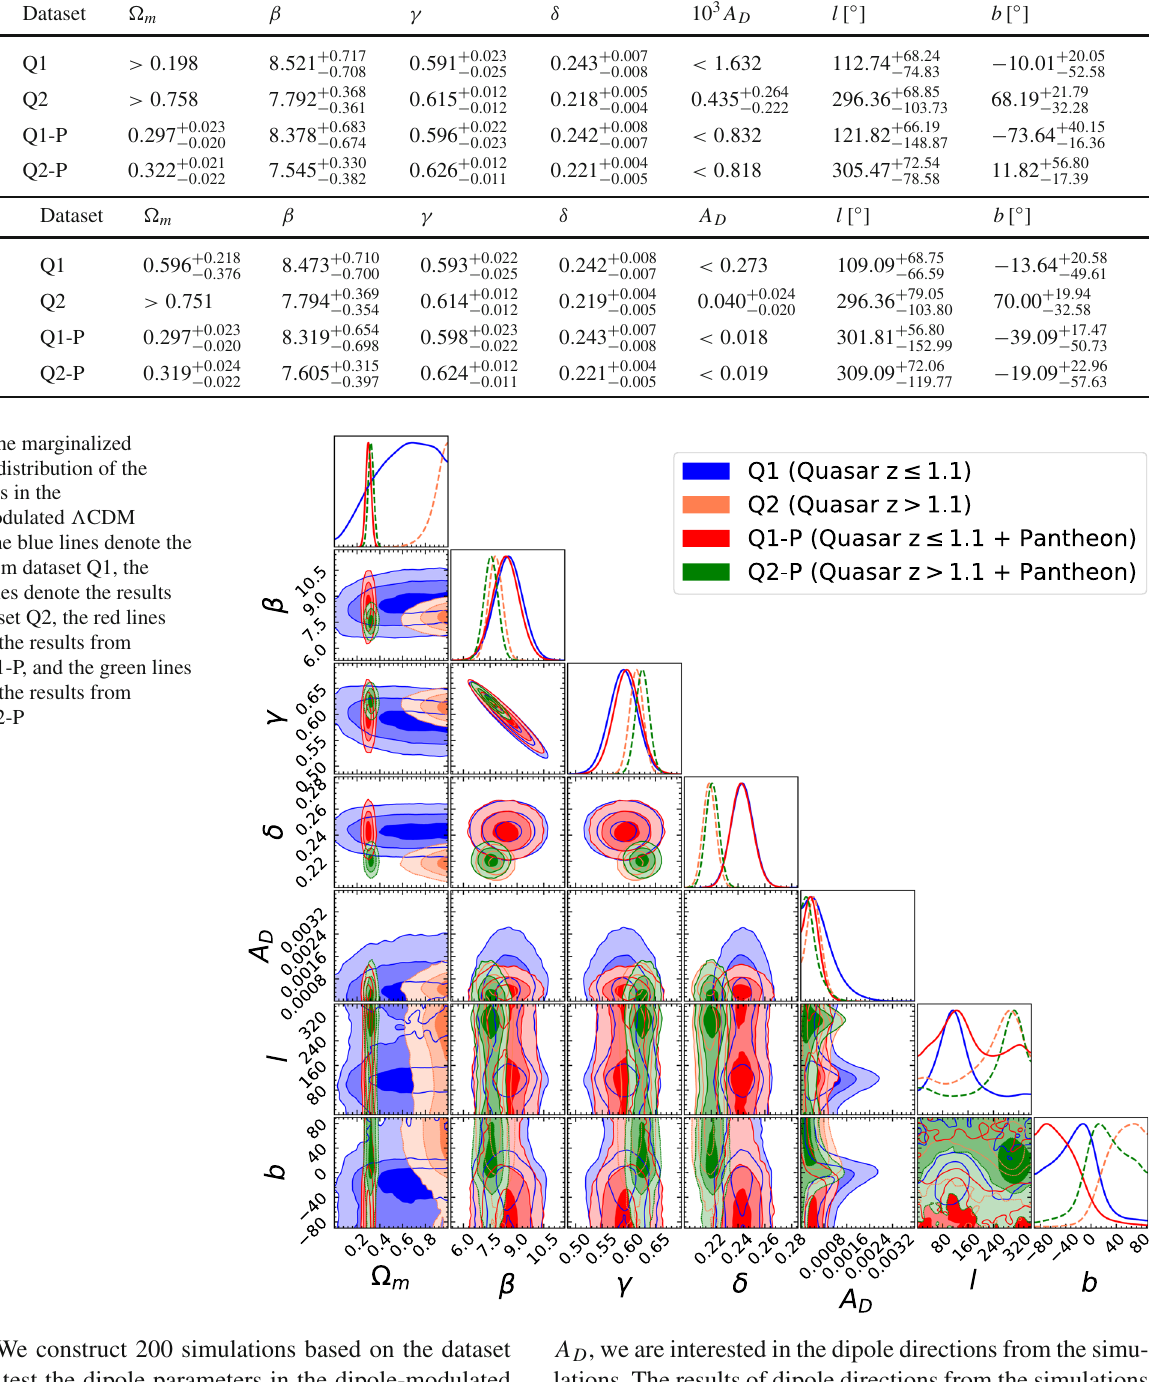
Table 3 The 68% confidence level constraints on the parameters in the dipole-modulated (cid:2) CDM model and Finslerian cosmological model. The datasets are Q1, Q2, Q1-P, and Q2-P. If the upper or lower limit of a parameter exists, we show the 95% confidence level of the parameter